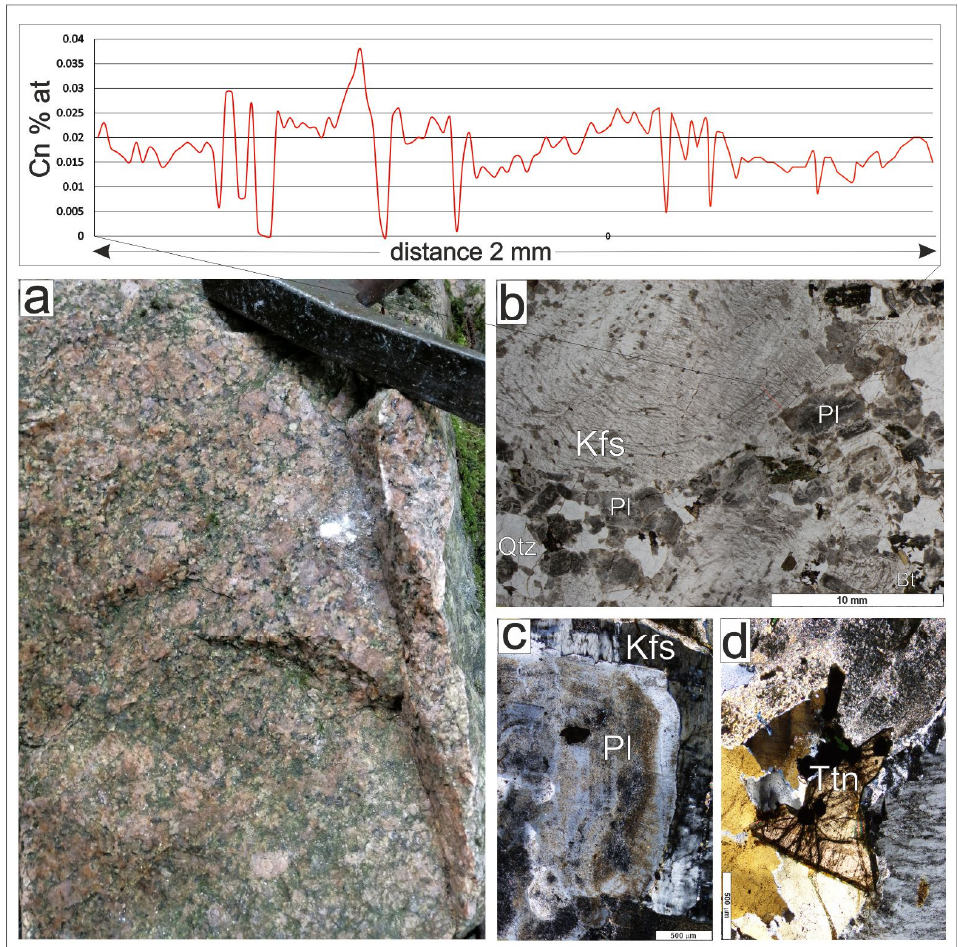
Figure 2. Petrographical features of the granitoid exotic block in different scales: ( a ) field image showing the porphyrocrystals of pink K-feldspars; ( b ) microphotograph showing the zonation of K-feldspar (Kfs) with the barium content profile (as celsjan molecule atomic percent) and its perthitic character (plane-polarized light); ( c ) zoned plagioclase (Pl) crystal, partially sericitized (crossed polarizers); ( d ) titanite crystal (Ttn) crystallizing as a late phase in the space between the feldspars.